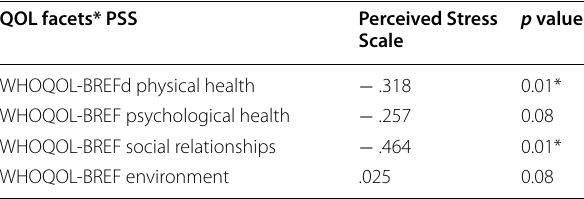
Table 6 Median and interquartile (IQ) range of Ways of